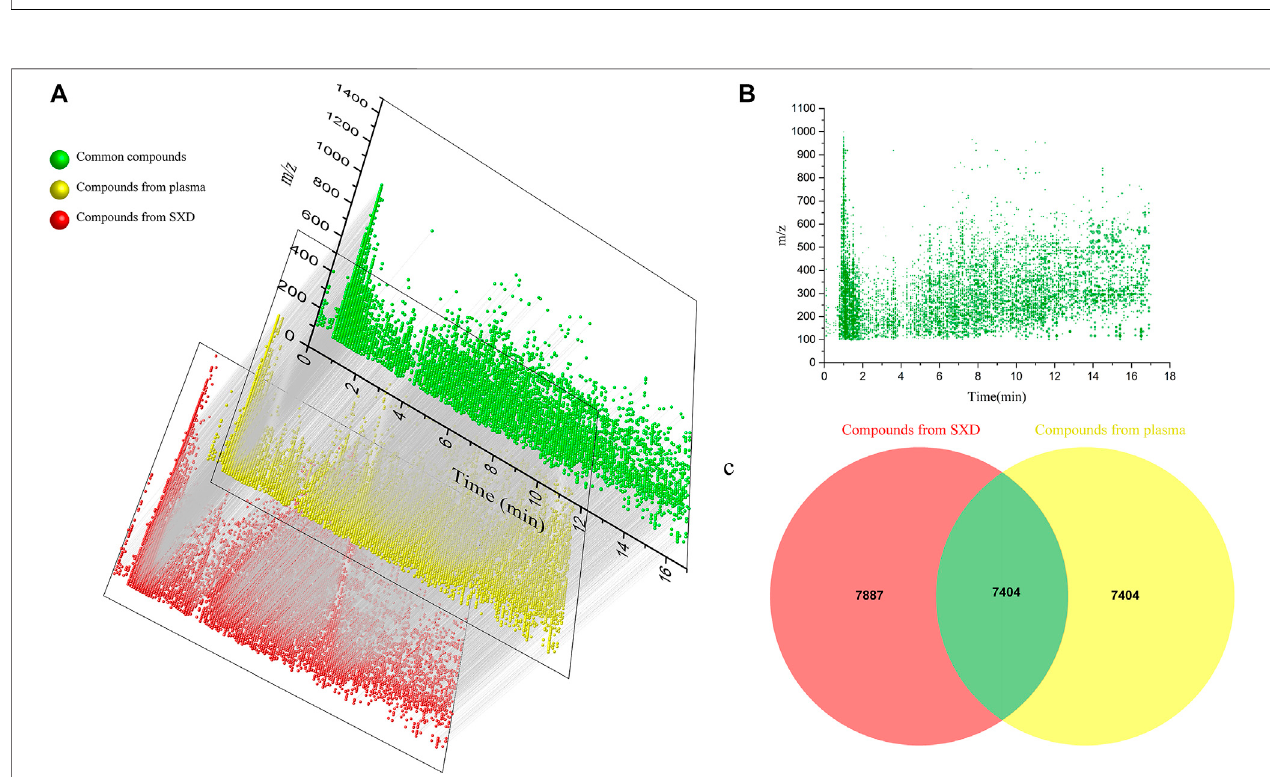
lower than the theoretical value of the proligand. The action mode of rosmarinic acid with 6D6U was shown in Figure 6A , the phenolic hydroxyl of rosmarinic acid could form hydrogen bond with the active amino acid residue HIE102, ASN60, and SER159,